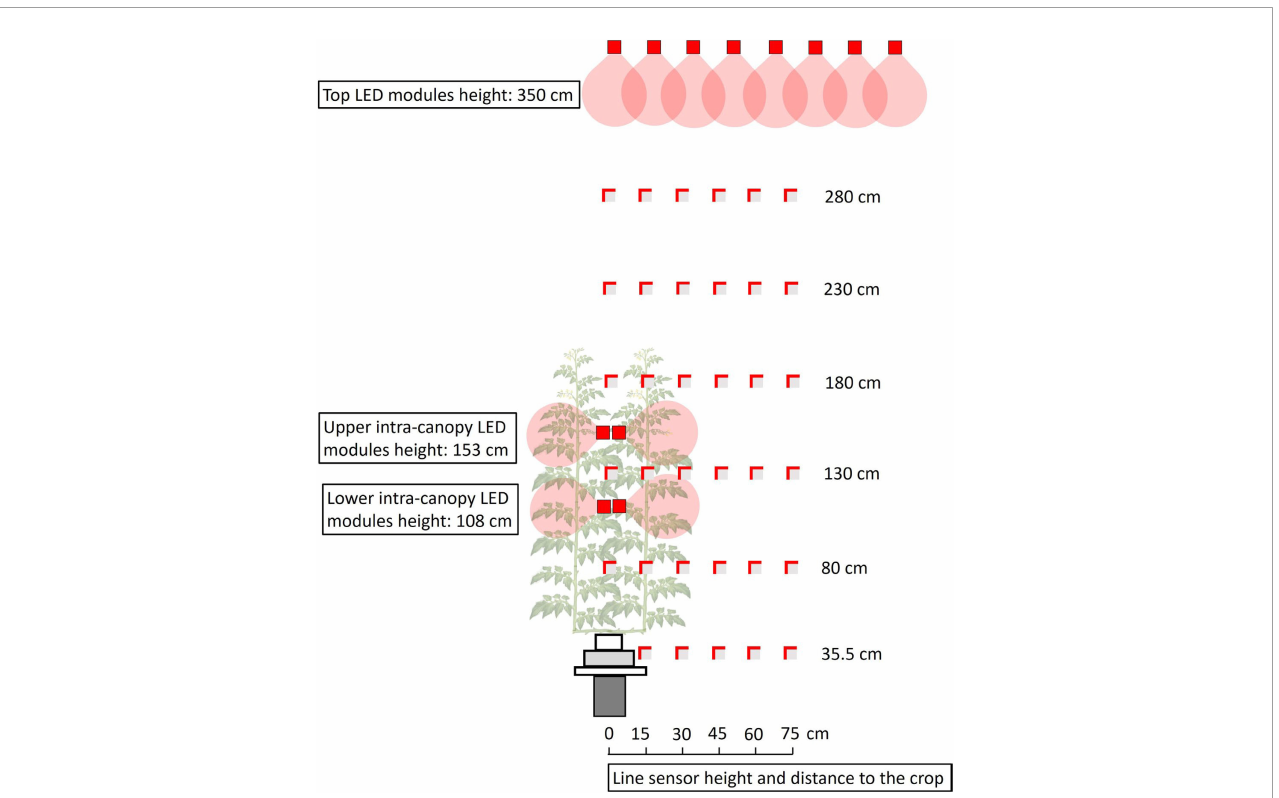
FIGURE 1 Side view of the light measurements in a tomato crop with LED lamps on top of the canopy and as intra-canopy lighting. Measurements were taken with a line sensor, indicated as a grey square with partly red borders. The line sensor was positioned parallel to the tomato double row at fi xed distances (0, 15, 30, 45, 60 or 75 cm) from the center of the double row at fi xed heights (35.5, 80, 130, 180, 230 or 280 cm). The two red borders on each grey square indicate the sides to which the line sensor was oriented in order to measure the vertical and horizontal incident light separately. Measurements for intra-canopy and top lighting were done when there was only light from one of the lighting systems at a